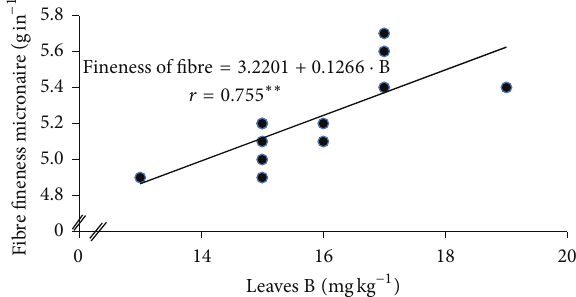
Figure 7: Regression curve between B content of leaves and fineness of fibre (micronaire) in the 2006 experiment ( ∗∗ 𝑝 < 0.01 ).